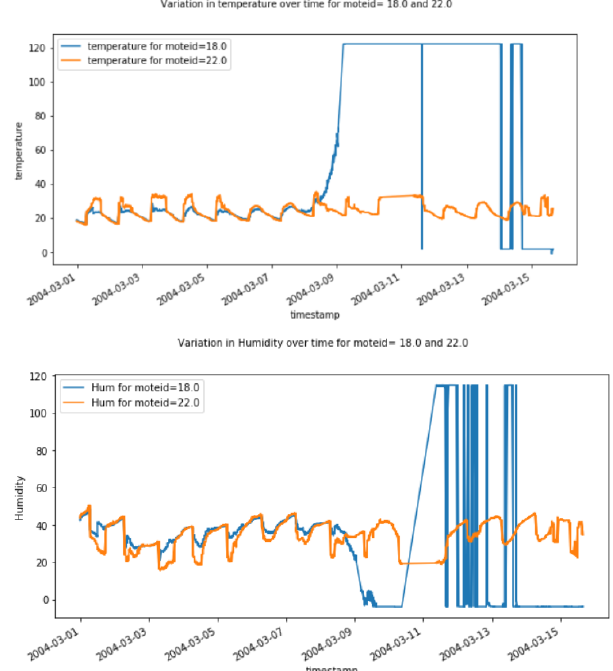
Figure 4. Depiction of faulty sensor readings of Temperature and Humidity with respect to a normal